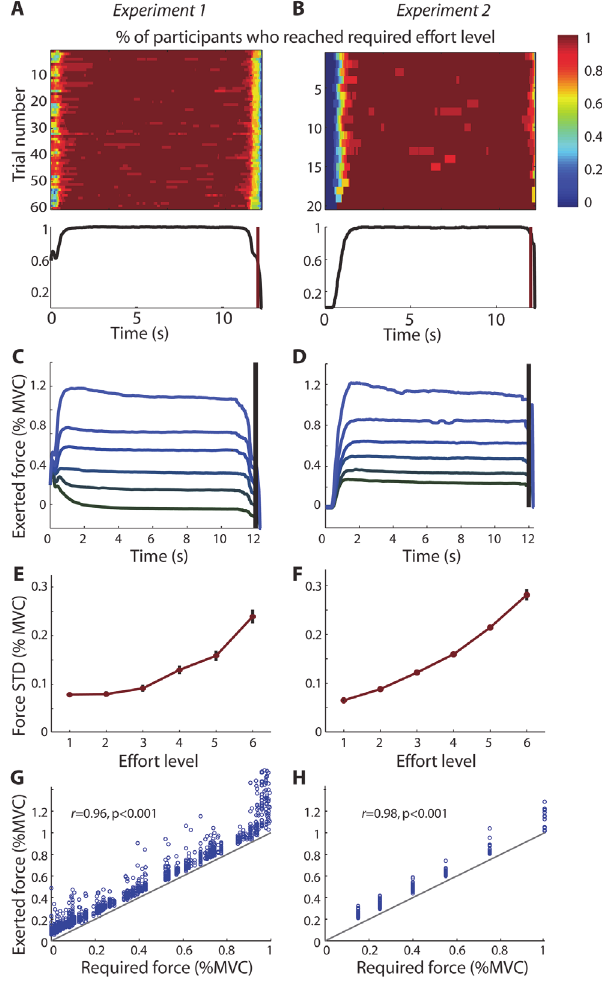
Fig 2. Force-grips: Completion of force-grip on effort trials. Force traces from trials in which a 12s grip was exerted in Experiment 2 (A,C,E,G) and Experiment 1 (B,D,F,H). (A,B) Trial-by-trial (top) and trial- average (bottom) percentage of participants that had reached the required effort level (color bar: 0 = no participant, 1 = all participants). (C,D) Group average 12s force trace for six different effort levels, expressed as percentage of participants ’ maximum voluntary contraction (MVC; Experiment 1: equally sized bins between [0,1]; Experiment 2: [0.15 0.25 0.4 0.55 0.75 1];). There was an offset at t = 0 in Experiment 1 because the 12s-effort directly followed the response which was indicated by briefly squeezing the gripper of the corresponding hand at a level of 0.35 (see Materials and Methods). (E,F) Within-trace average variability (STD = standard deviation) for the same six effort levels increases with increasing difficulty (group average ± SEM). (G,H) Required force levels are plotted against mean exerted force levels for every effort trial, showing a strong correlation in both experiments. The produced force consistently exceeded the required force level by a small amount because participants were instructed to maintain their force just above the target bar and because they kept a ‘ safety margin ’ to account for slight variations in